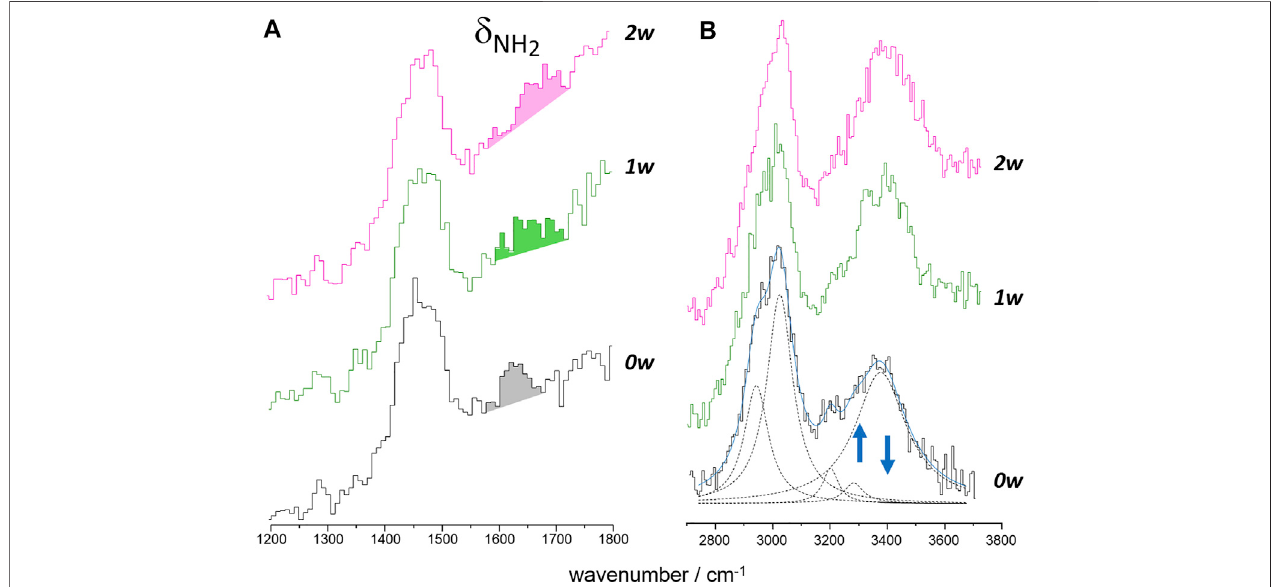
FIGURE 6 | INS spectra of ChCl:urea:water mixtures recorded using MAPS, with an incident energy of 2016 cm − 1 [0 ≤ q ≤ 9 Å − 1 , (A) ] and 5,243 cm − 1 [0 ≤ q ≤ 12 Å − 1 , (B) ].InpanelB,thedashedlinesrepresentthecontributionstothebest fi tadjustmentofthe0wspectrumandthearrowsindicatetheobservedintensitychanges upon hydration (best fi t lines are omitted for 1w and 2w spectra for